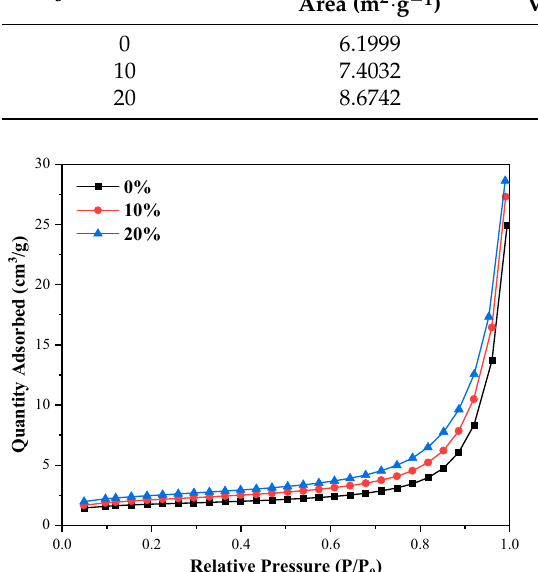
Figure 9. N 2 adsorption desorption isotherm of C 3 S-C 3 A paste.